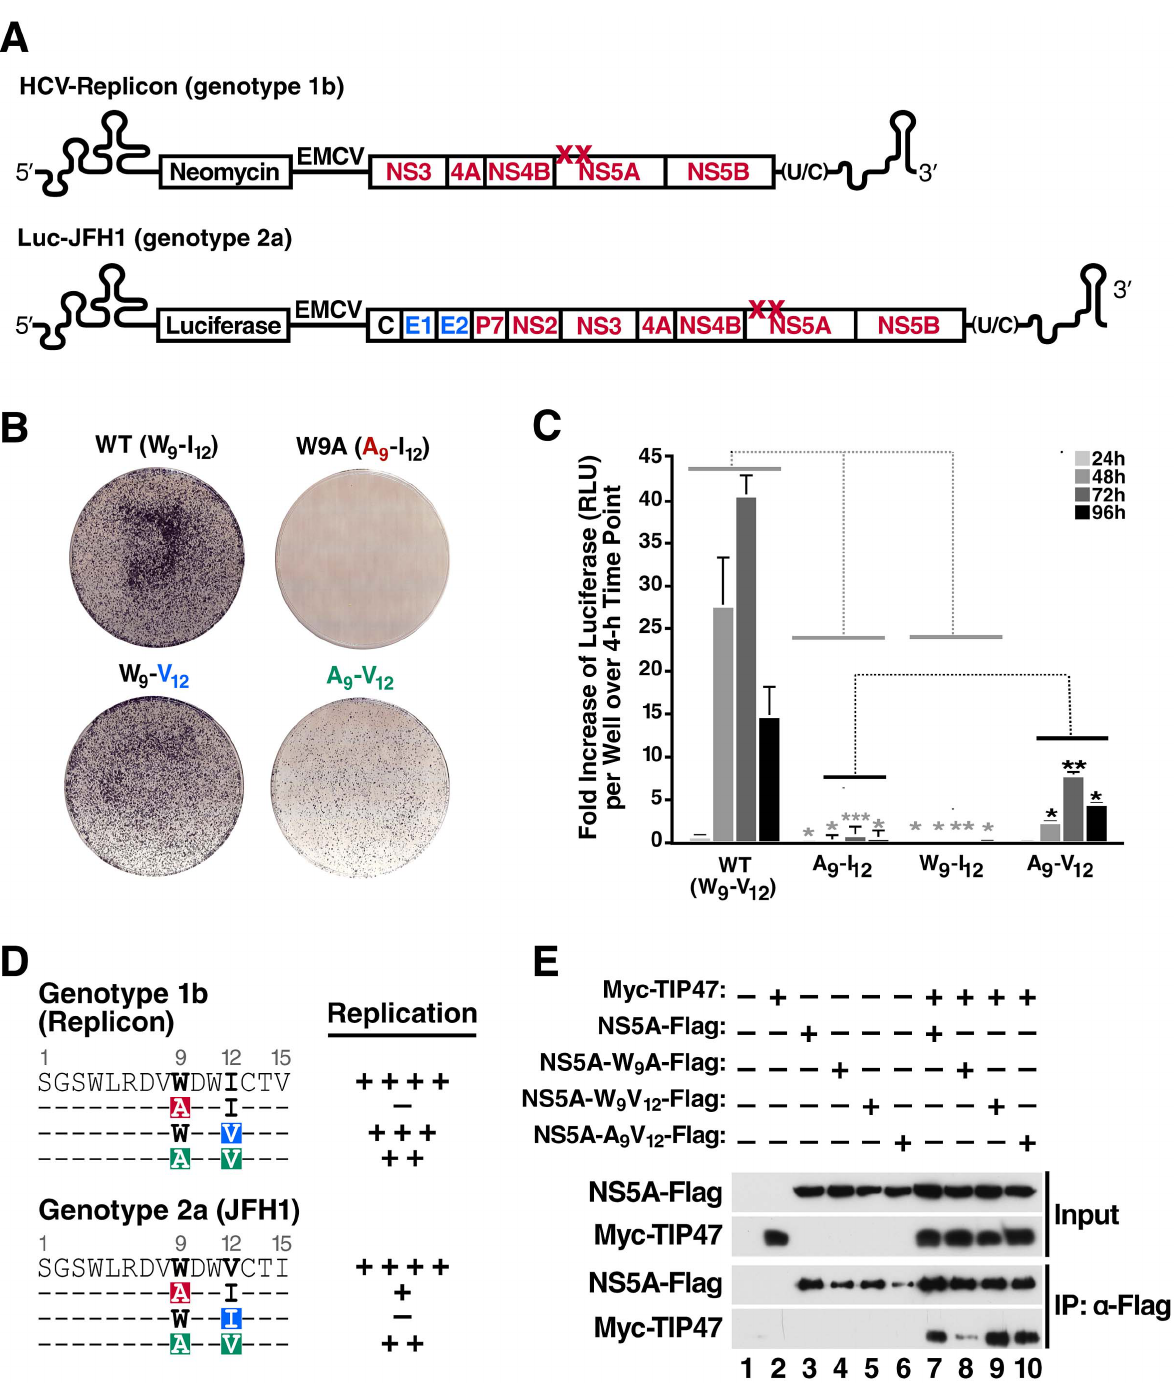
Figure 3. TIP47 is involved in HCV RNA replication via interaction with NS5A. A) Schematic representation of the HCV Replicon (genotype 1b) and Luc-JFH1 (genotype 2a), with mutations at position 9 and 12 in the NS5A N-terminus. B) Crystal violet-stained Huh7.5 cells transfected with wild-type or mutant HCV replicon RNA (genotype 1b). 24 h post-transfection, G418 was added to the medium (1 mg/ml). Cells were kept under selective pressure for 4 weeks before being stained with crystal violet. These results are representative of three independent experiments. C) Luciferase assay of Huh7.5 cells transfected with wild-type Luc-JFH1 RNA (genotype 2a) or Luc-JFH1 RNA containing indicated NS5A mutations. Values are expressed as fold increase of luciferase (RLU) per well, over a 4 h time point (mean 6 standard deviation; n=3, *P , 0.05, **P , 0.01, ***P , 0.001). The decrease of A 9 -I 12 and W 9 -I 12 is significant in relation to WT (indicated in grey *), whereas the increase in A 9 -V 12 is significant in relation to A 9 -I 12 where indicated (indicated in black *). D) Amino acid sequences of the NS5A N-terminus of HCV replicon (genotype 1b) and HCV- JFH1 (genotype 2a). Positions 9 and 12 are highlighted in bold black and mutations are highlighted in color. Summary of respective replication phenotypes in the HCV replication assay (genotype 2a, Figure 3B, C). Wild-type replication phenotypes were set as equal to ( ++++ ) in their respective assays, while reduced replication levels were defined in the Replicon assay as ( +++ ) for , 90% of wild-type colonies, ( ++ ) for , 20% colonies, or ( 2 ) for no colonies. In the Luciferase assay, luciferase values were described as ( ++ ) for values , 19% of wild-type, ( + ) for , 2%, and ( 2 ) for values below 1%.